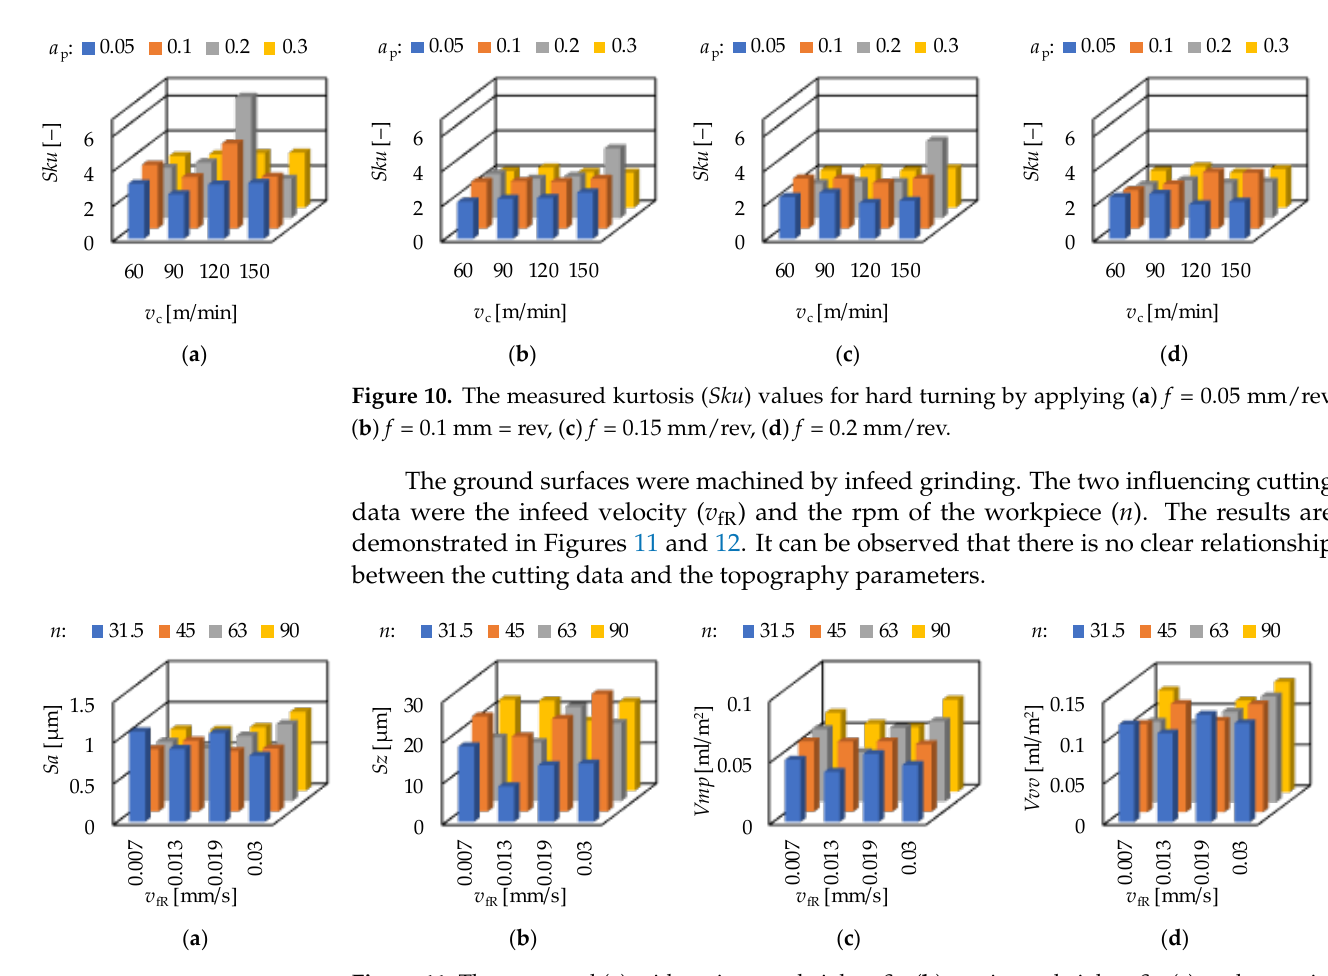
Figure 11. The measured ( a ) arithmetic mean height— Sa ; ( b ) maximum height— Sz ; ( c ) peak material volume— Vmp and ( d ) valley void volume— Vvv values for grinding.